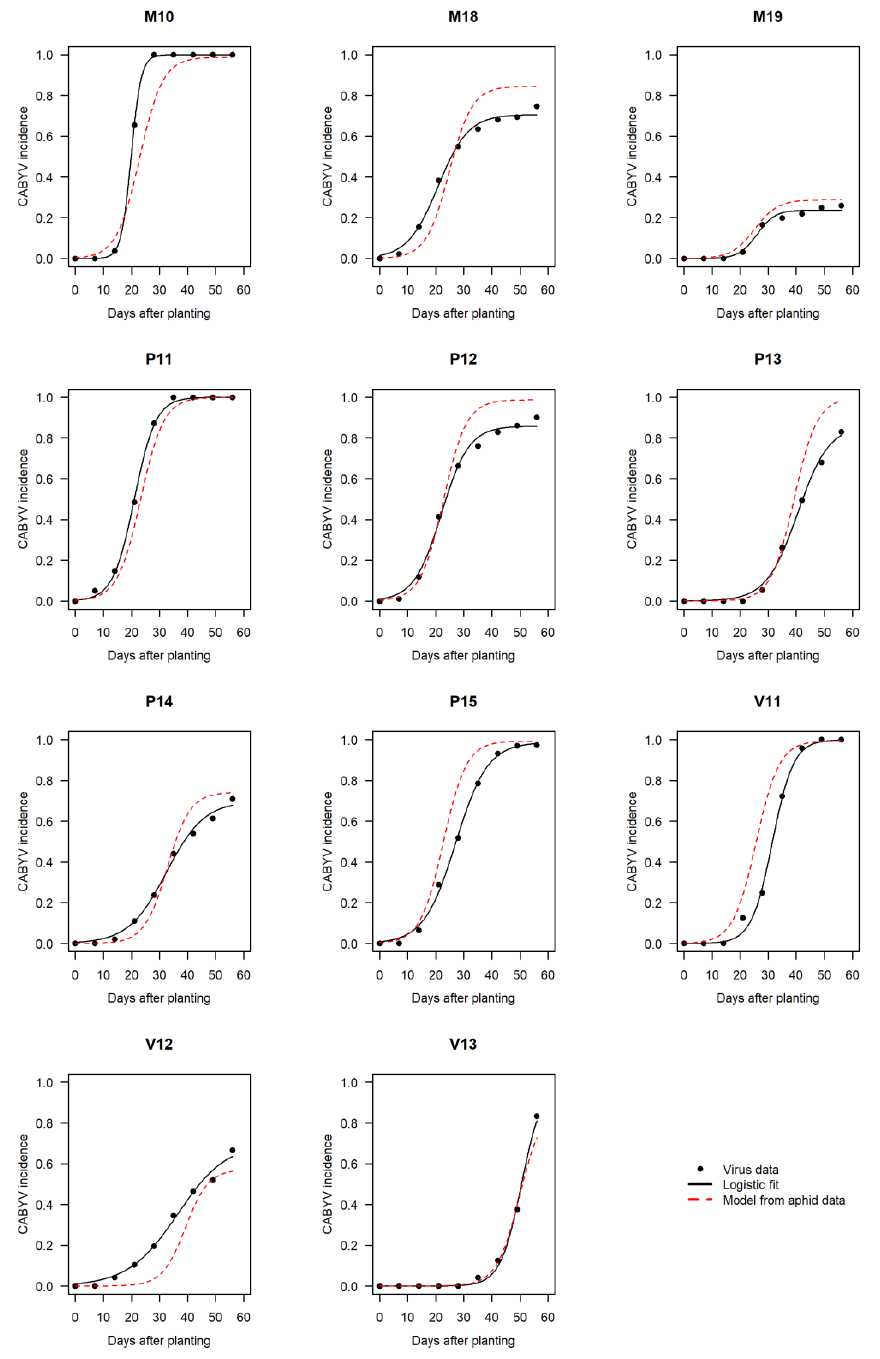
Figure 4. Observed and modelled CABYV epidemic dynamics in melon crops for eleven field trials conducted in Avignon between 2010 and 2019. Black dots represent observed cumulative incidences (proportion of infected plants expressed as a ratio). Black solid lines are fitted curves (logistic model). Red dashed lines represent rebuilt dynamics from the best predictive aphid